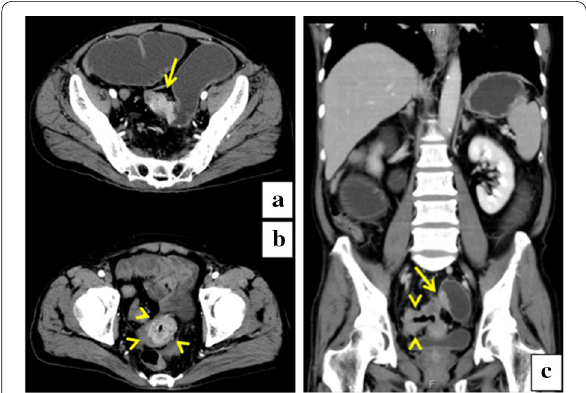
Fig. 2 a–c CT revealed a 6.5-cm-sized sigmoid colon cancer. Tumor invasion was extended to the ileum and caused the small intestine ileus. The arrowhead shows sigmoidal tumor, and the arrow shows ileal